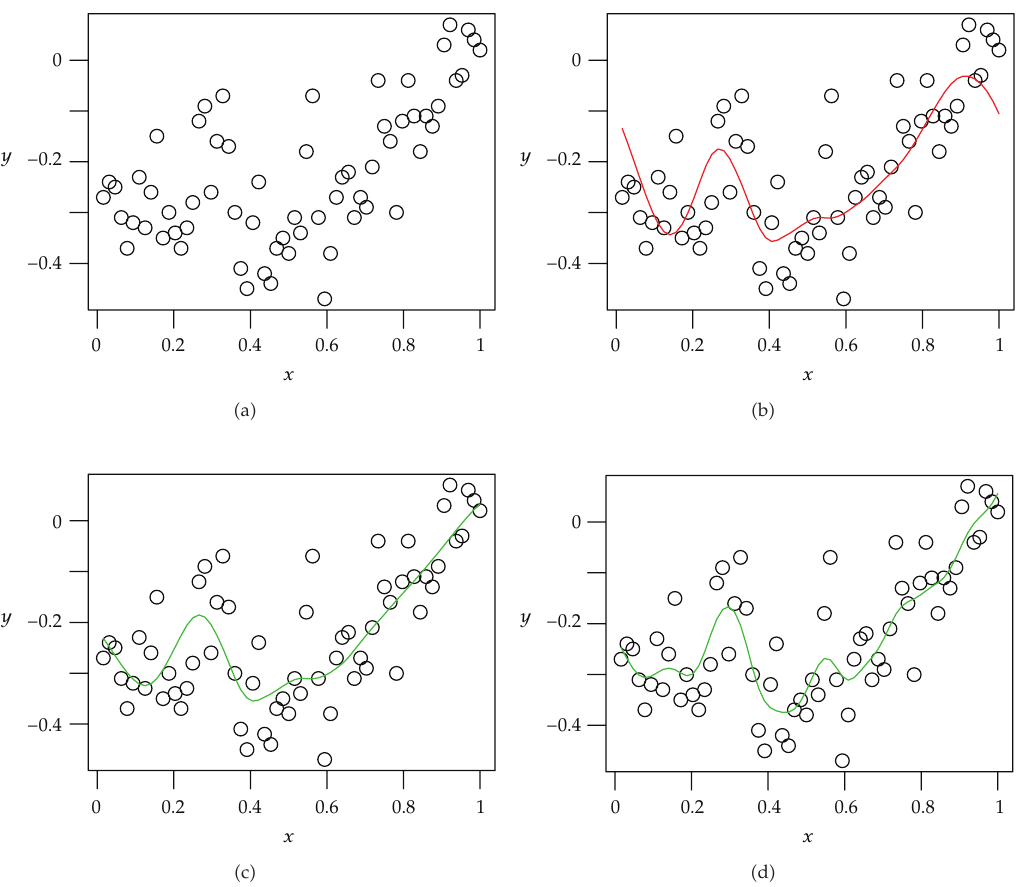
Figure 6: Curve estimation for the second data: (cid:5) a (cid:6) noisy data, (cid:5) b (cid:6) the fitting by (cid:7) 5 (cid:8) , (cid:5) c (cid:6) the fitting by first proposed method, and (cid:5) d (cid:6) the fitting by the second proposed method. The green line is the